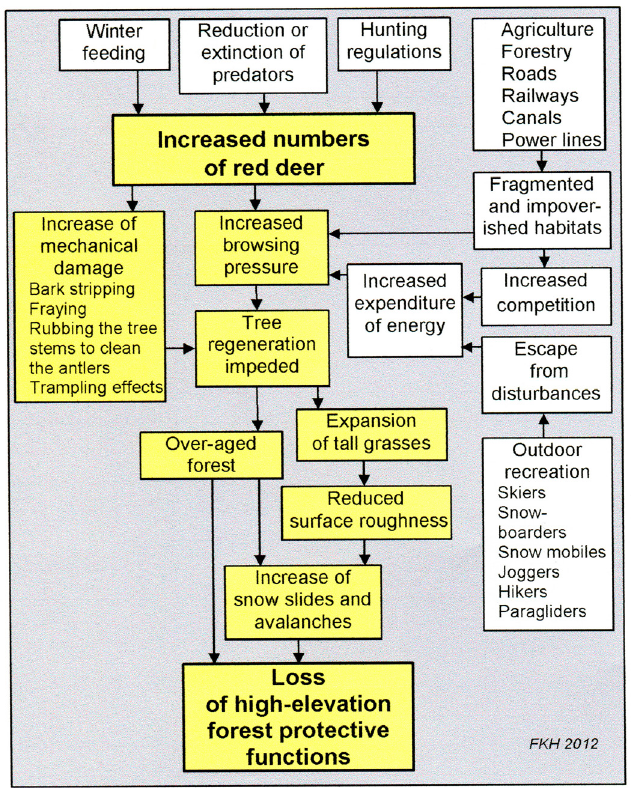
Figure 3: Causes (white boxes) and consequences (yellow boxes) of over-sized red deer populations and their impact on the protective functions of high-elevation